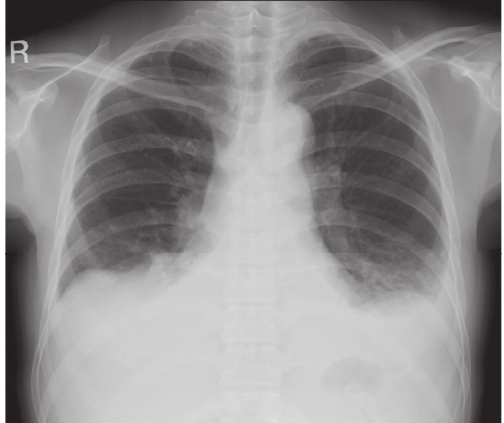
Figure 1: Chest X-ray on admission showing bilateral dullness of the costophrenic